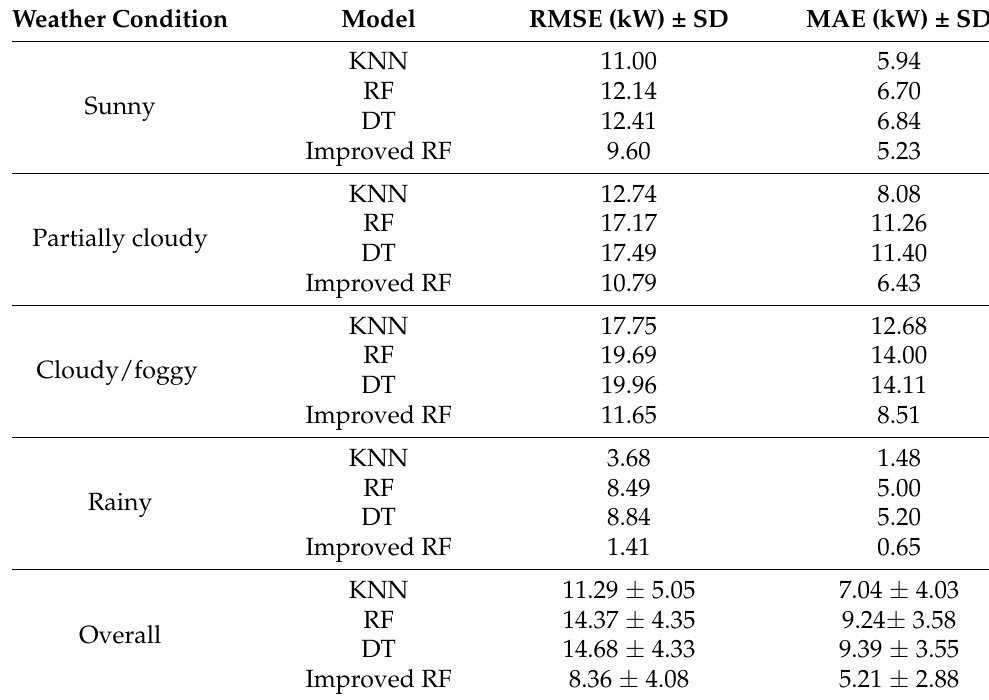
Table 4. Forecast error metrics of the simulated predictors for various weather